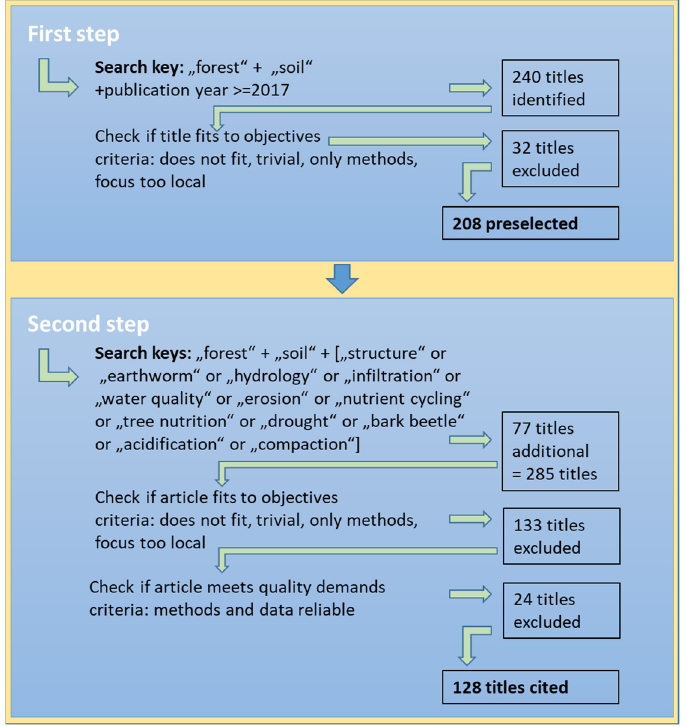
Figure 2. Iterative selection process of the literature research. The publication years of the remaining 128 articles cited after the final